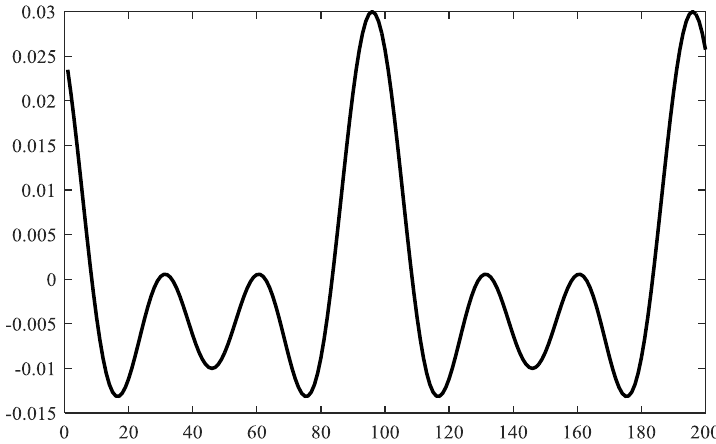
Figure 17. Discrete cosine transform (DCT) coefficients for h = 2, h = 4, h = 6.